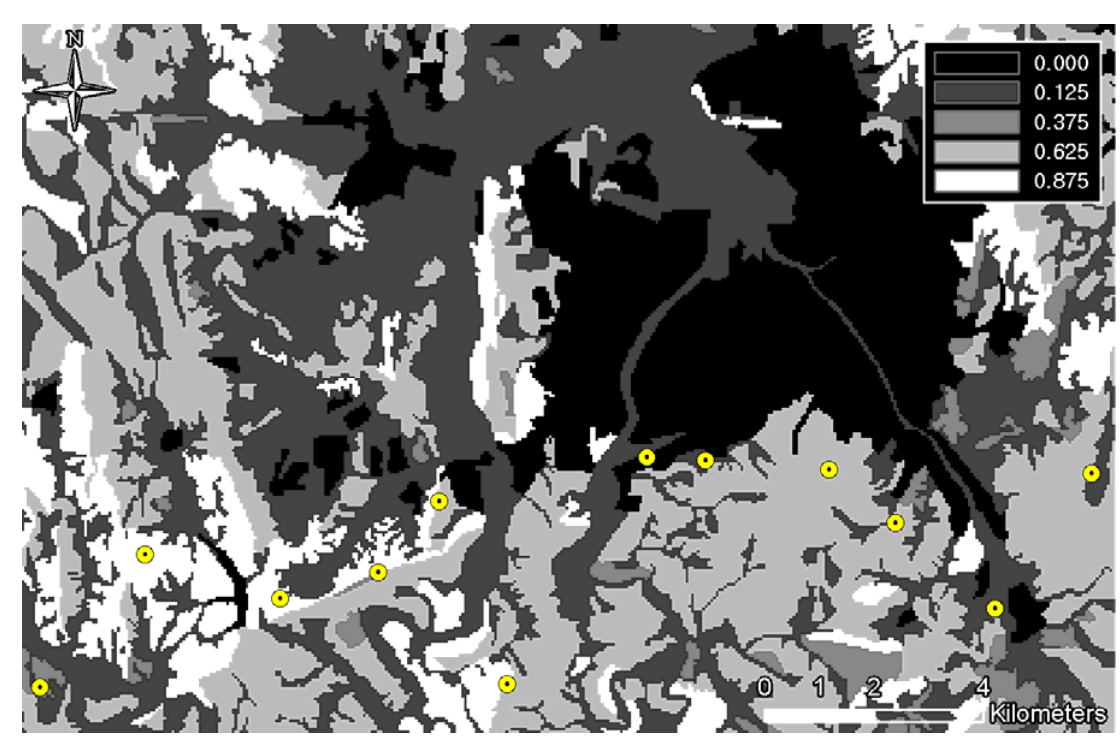
Figure 4. Concealment